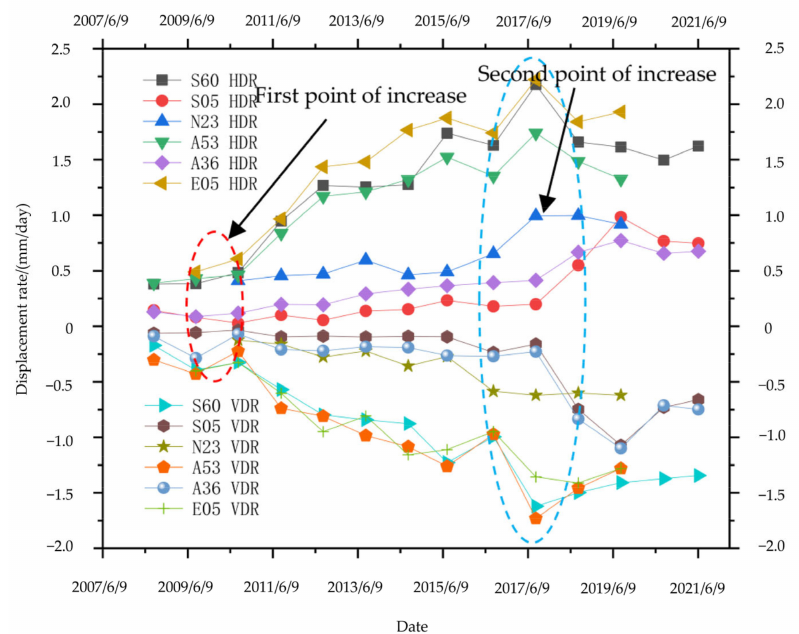
Figure 15. Graphs showing the rate of change of displacement as a function of time at repre- sentative monitoring points (HDR denotes the horizontal displacement rate; VDR the vertical displacement